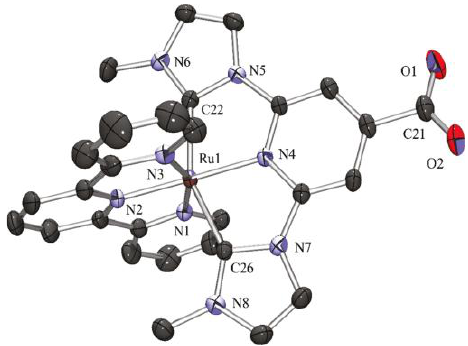
Figure 34. ORTEP drawing of complex 43b [142] (Reprinted with permission from Park, H.-J.; Kim,